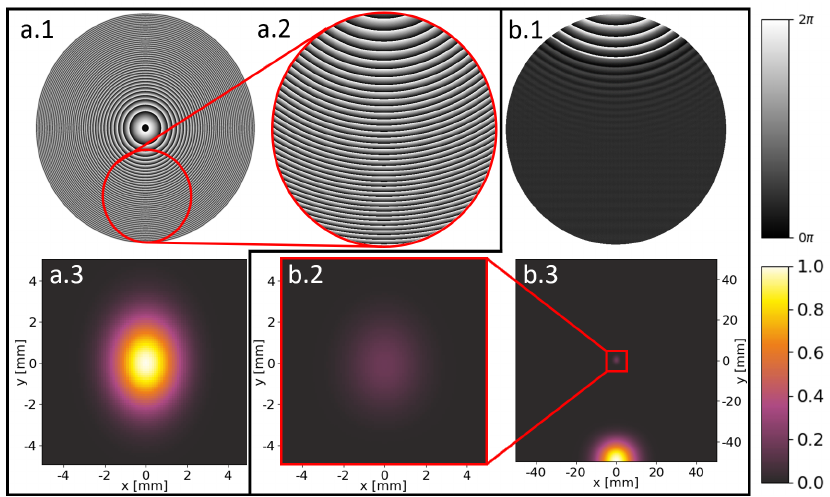
Figure 2. Two concepts of designing off-axis lens—analytical equation (a) and re-propagation of ideal focal spot (b). Subimages ( a.1 , a.2 ) show the phase distributions of the whole lens designed with the analytical equation in the non-paraxial approach and its part taken for image reconstruction, respectively. The theoretical focal spot obtained from the cut-out lens can be seen in ( a.3 ). The phase distribution obtained after back-propagation of the predefined focal spot is shown in the subfigure ( b.1 ) (assuming also Gaussian shape illumination resulting from the divergence of the used radiation source). The image reconstructed using this method is presented in ( b.2 ). The same focal plane can be seen in wider scale in the subimage ( b.3